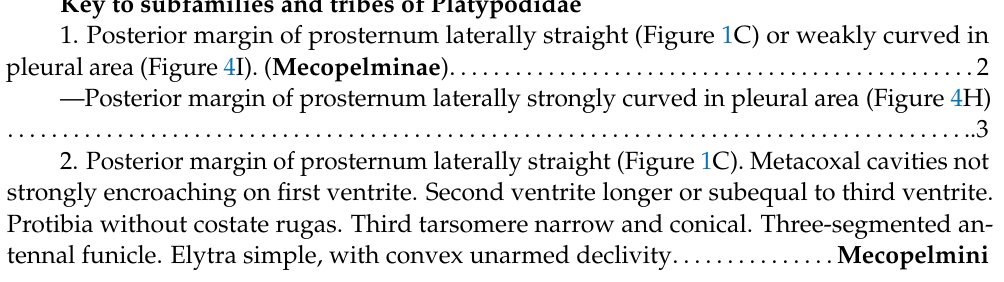
Figure 3. Xyleborites longipennis , holotype, body, lateral view, Florissant: ( A ) without alcohol; ( B ) with alcohol.